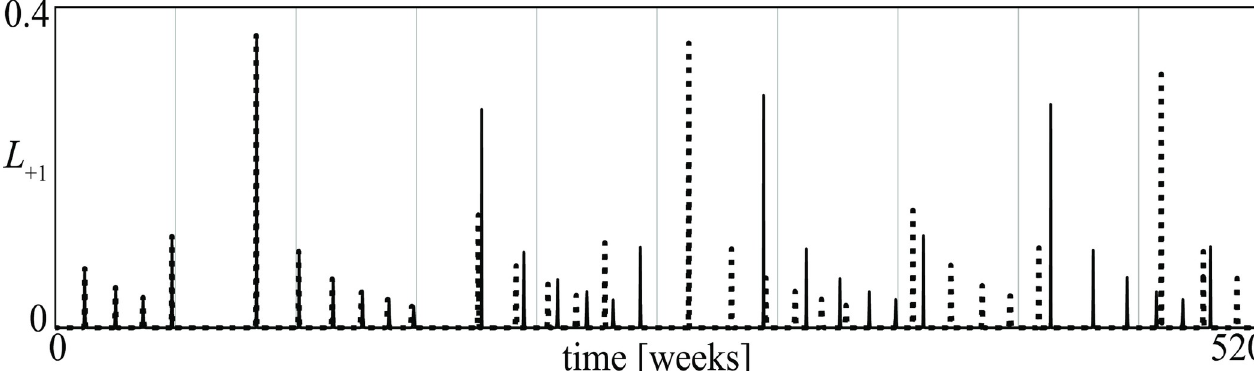
Fig 15. Time evolution of the losses in the conflict described in Fig 14. The continuous curve is as in Fig 14 while the dotted one has been obtained for a 1% variation of the initial loss of the D group.